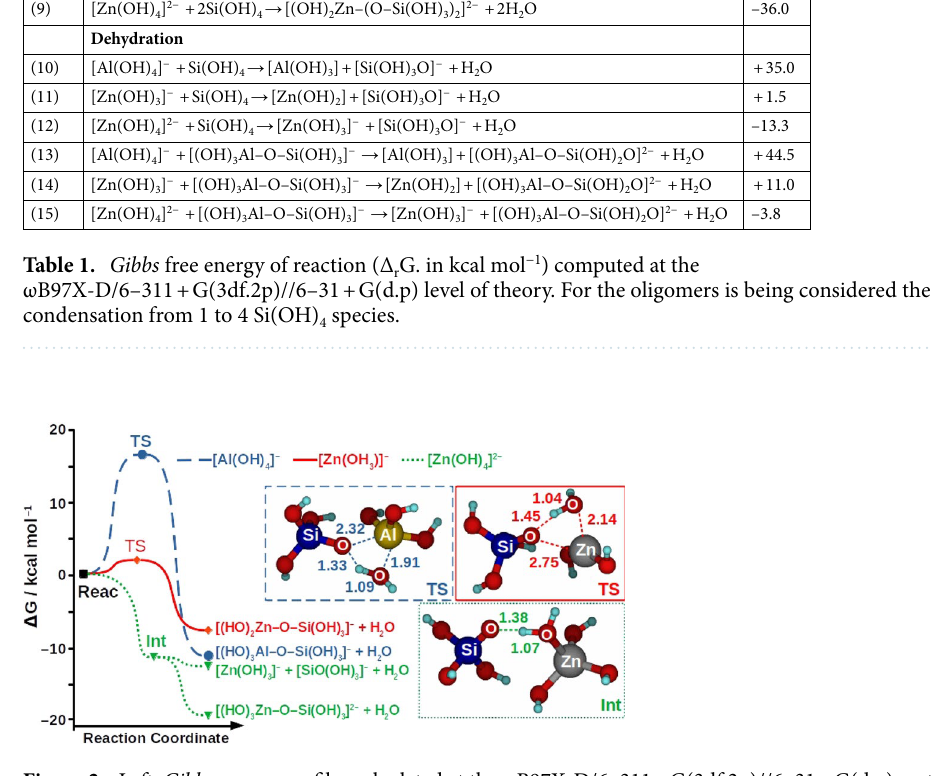
Figure 2. Left: Gibbs energy profiles calculated at the ωB97X-D/6–311 + G(3df.2p)//6–31 + G(d.p) method for the [Al(OH) 4 ] − + Si(OH) 4 . [Zn(OH) 3 ] − + Si(OH) 4 . and [Zn(OH) 4 ] 2− + Si(OH) 4 reactions. The Gibbs energy values (in kcal mol − ) for each reaction profile are relative to the reactants (Reac). Structures of the transition states (TS) and intermediate (Int) calculated at the ωB97X-D/6–31 + G(d.p) level of theory. Some relevant bond distances (in Å) are included in the